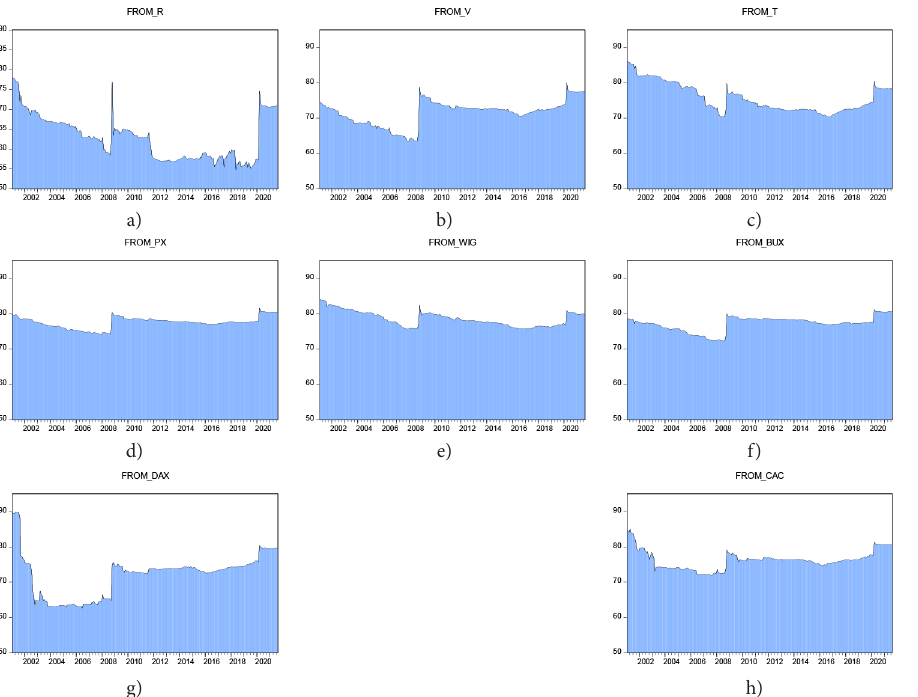
Figure 4. Directional volatility spillovers, from each stock market: a – Latvia; b – Lithuania; c – Estonia; d – Czech Republic; e – Poland; f – Hungary; g – Germany; h – France (source: results obtained by the